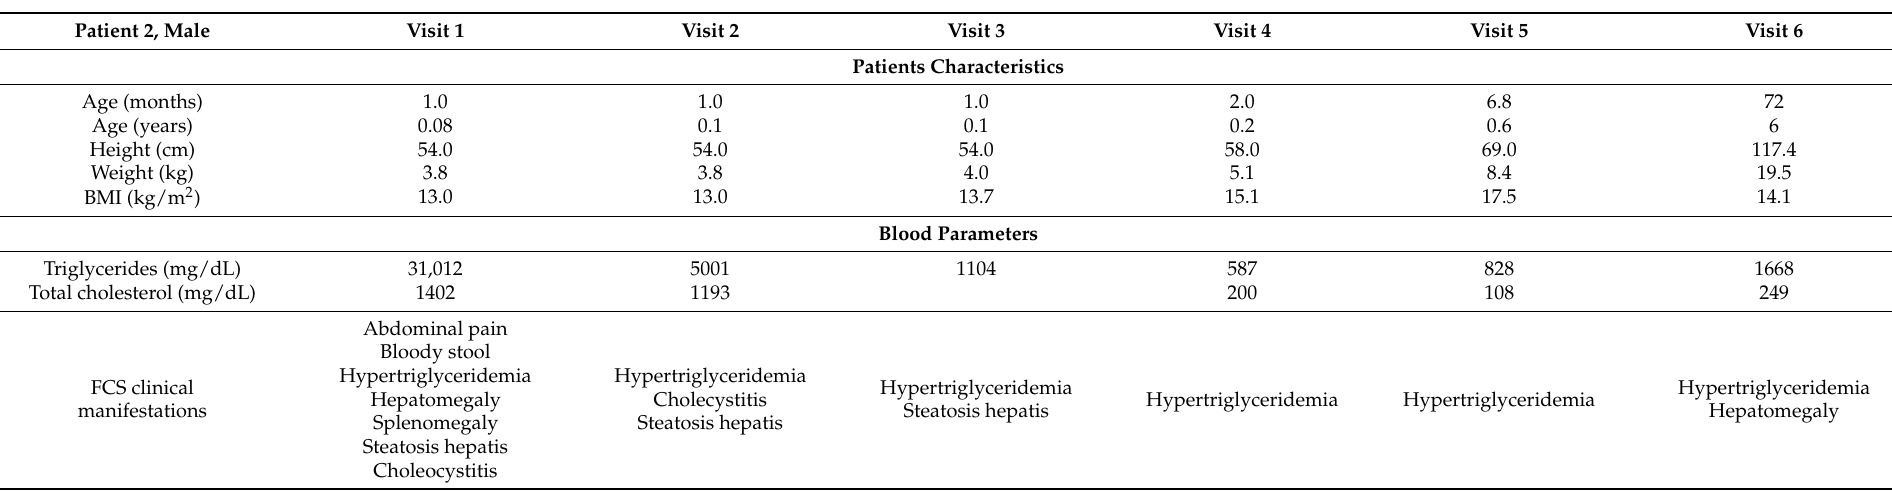
Table 4. Patient 2—blood parameters and nutrients